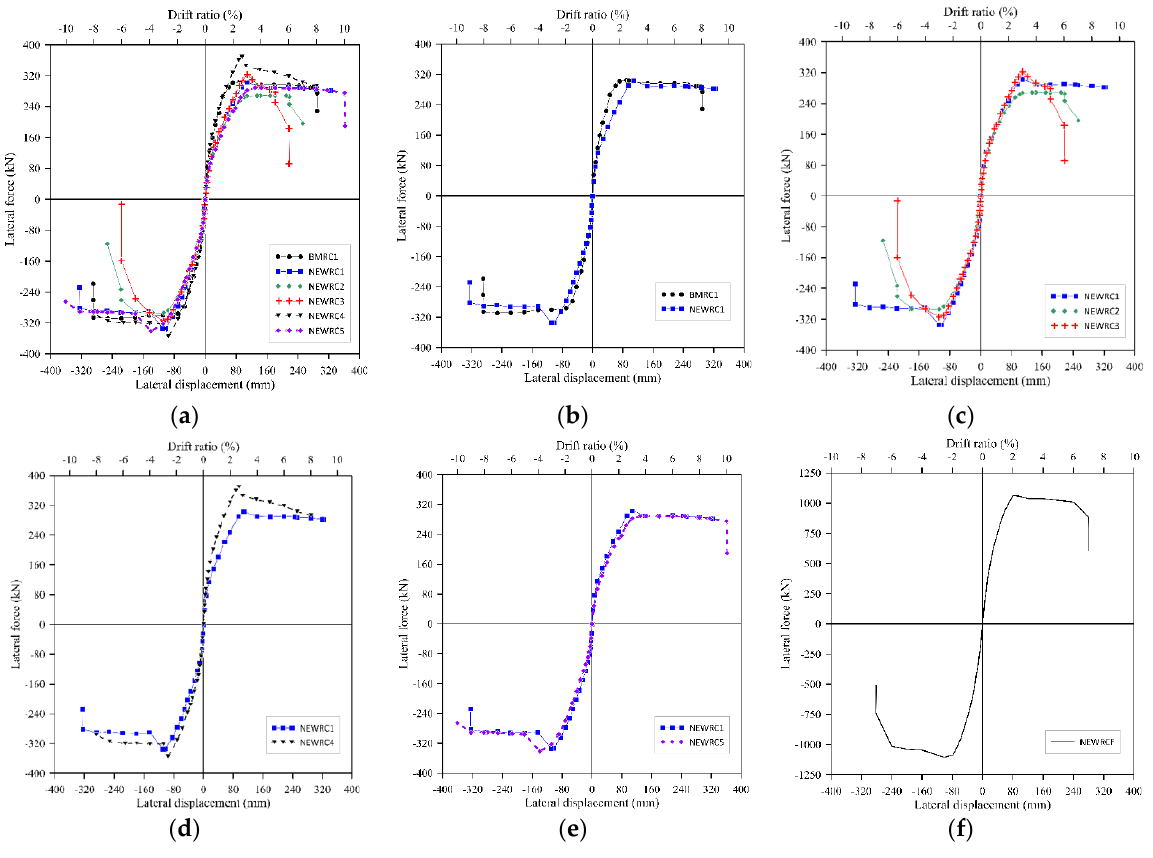
Figure 9. Backbone curves: ( a ) All specimen; ( b ) BMRC1 and NEWRC1; ( c ) NEWRC 1, 2, and 3; ( d ) NEWRC 1 and 4; ( e ) NEWRC 1 and 5; ( f ) NEWRCF.